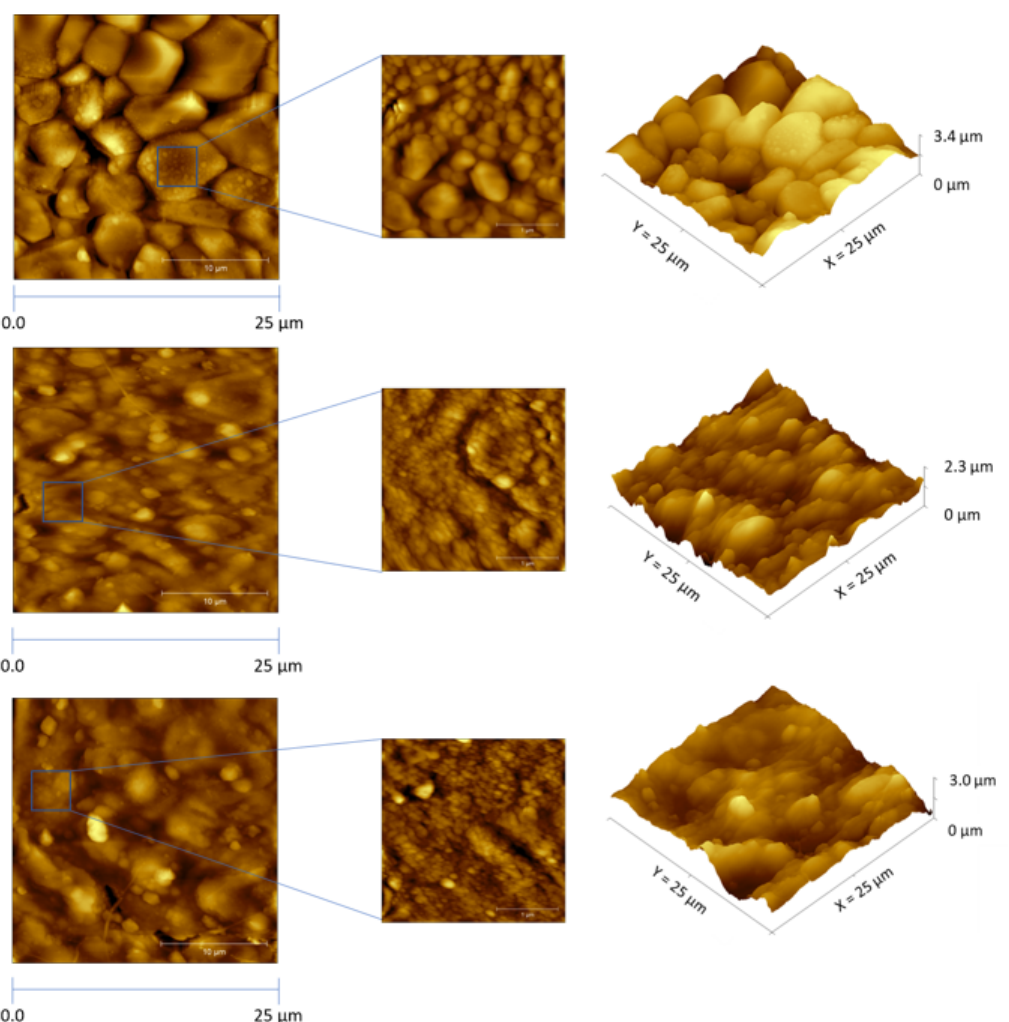
Figure 4. AFM images in ( left ) 2D and ( right ) 3D collected at the AuSPE surface ( top ) before and ( middle ) after Py monomer electropolymerization in the presence of template protein, followed by (bottom) template extraction from the MIP film.